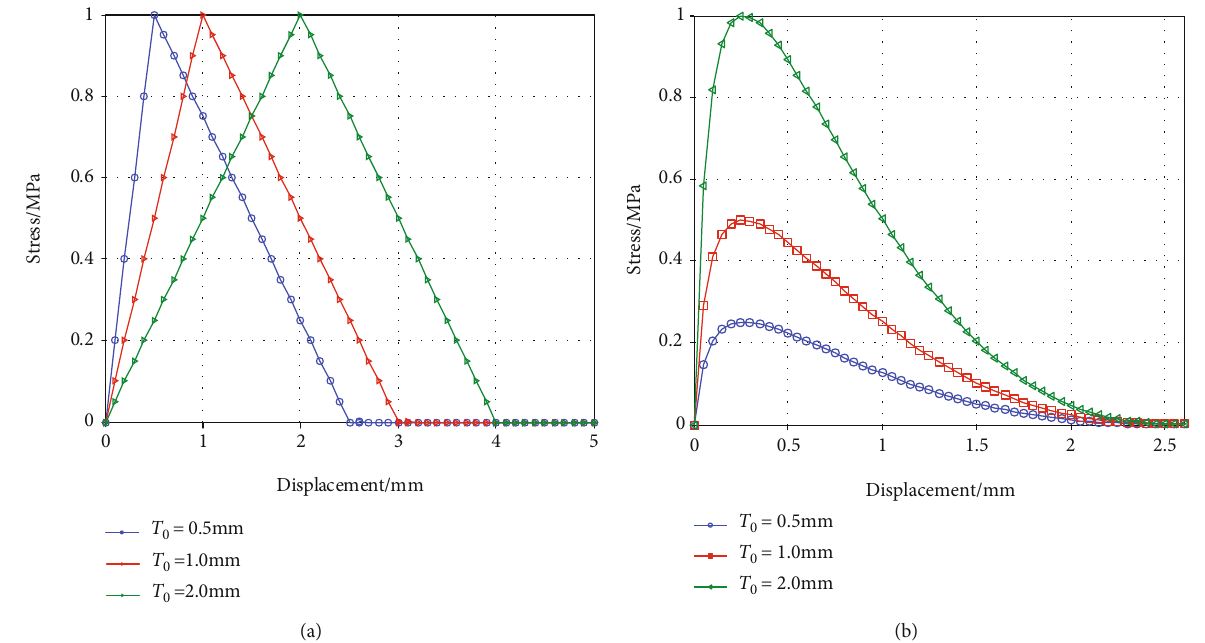
Figure 23: Illustration of thickness dependence of the normal traction of (a) bilinear CZM in ABAQUS and (b) PPR